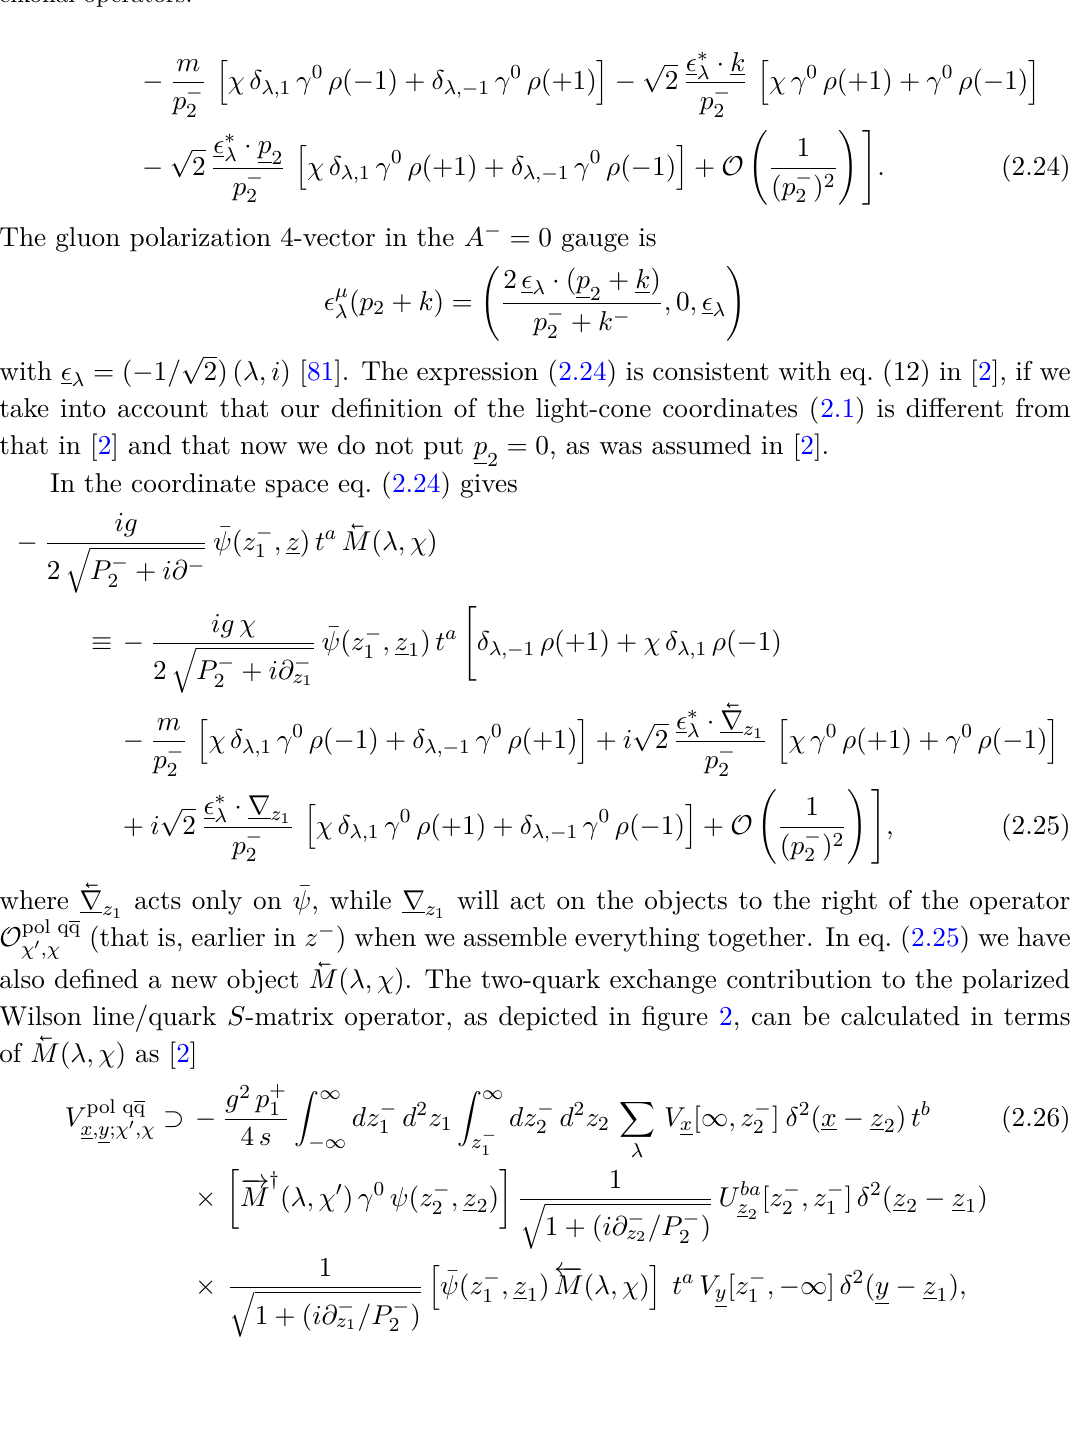
Figure 2. The diagram representing the quark field contribution to the sub-eikonal and sub-sub- eikonal